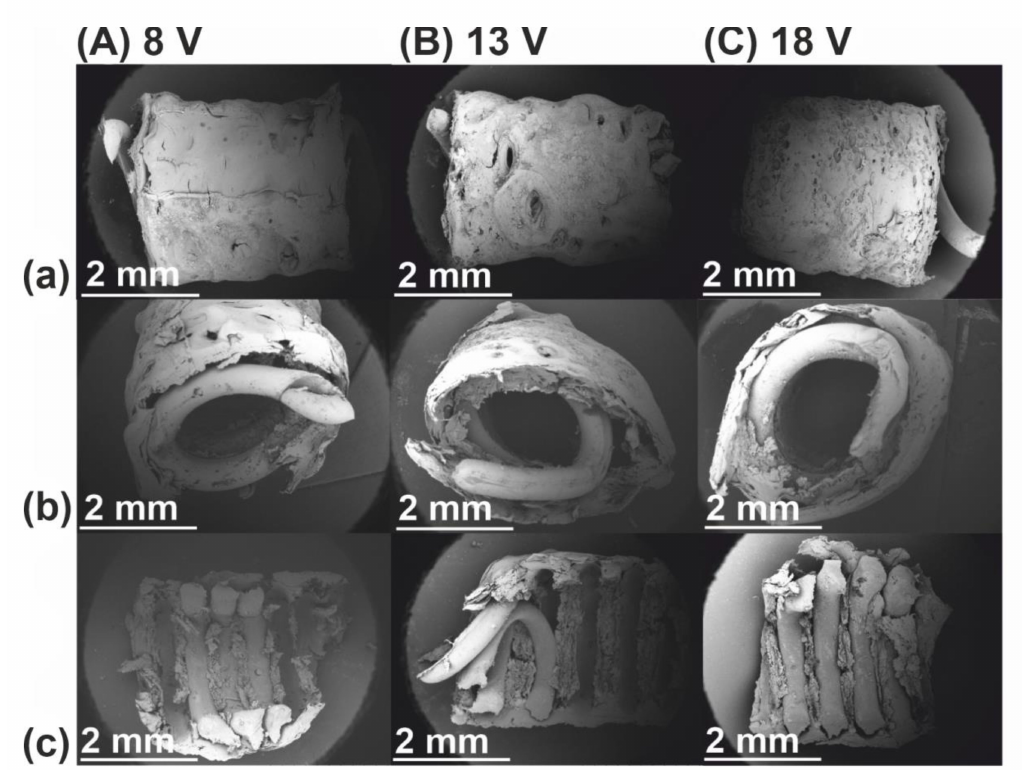
Figure 4. SEM images of 30x magnification of ( a ) longitudinal view, ( b ) transverse cross-section view, and ( c ) inner sidewall view of hybrid implants obtained for the electrodeposition process initiated at ( A ) 8, ( B ) 13, and ( C ) 18